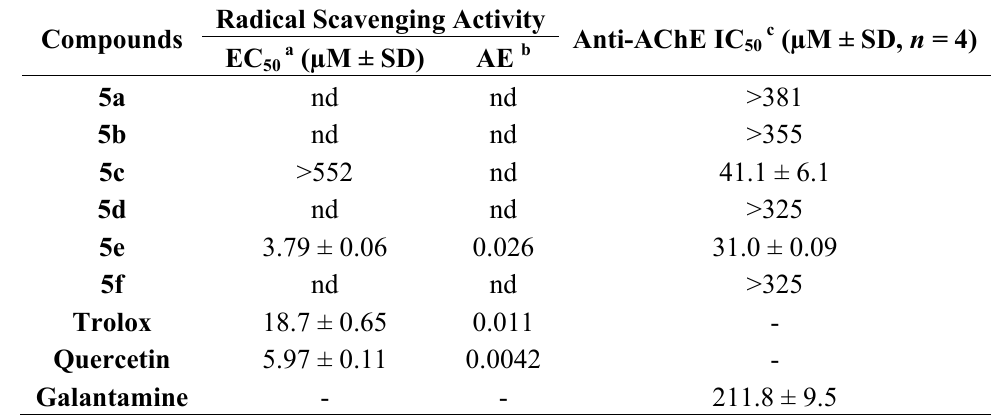
Table 2. Radical scavenging activity and acetylcholinesterase inhibitory effect of xanthenediones ( 5